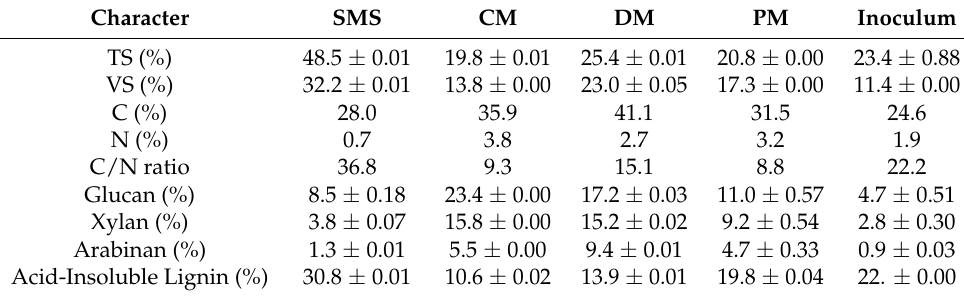
Table 1. Characterization of substrates and inoculum.